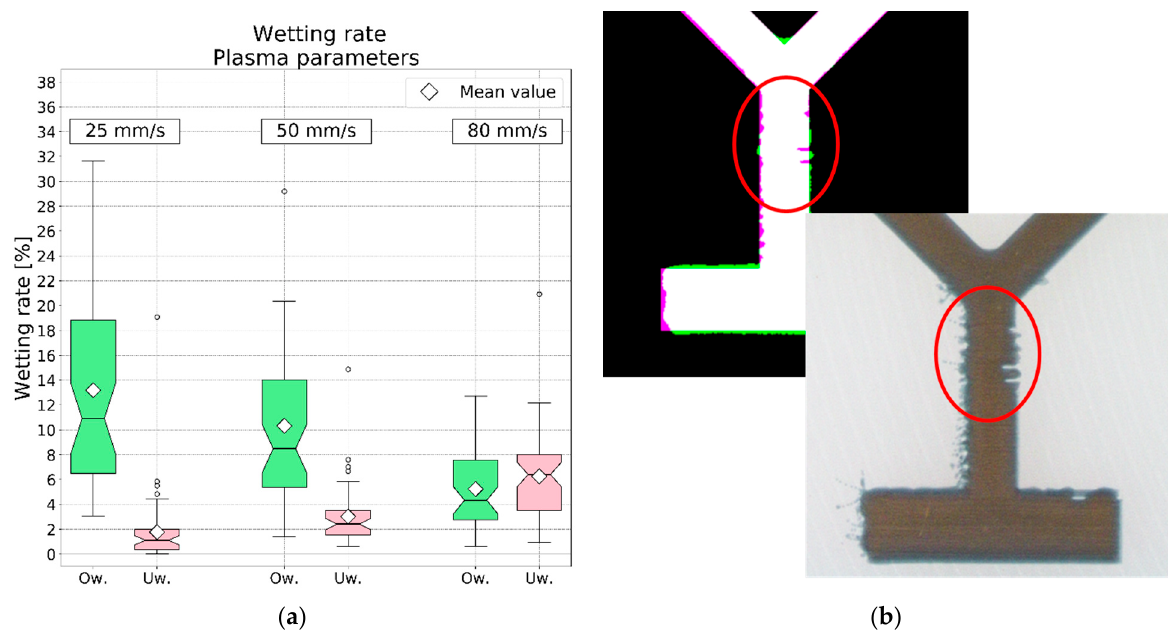
Figure 8. ( a ) Box plot diagram of wetting rates including overwetting (Ow.) and underwetting (Uw.) by varied plasma parameters ( b ) Example of a 50 mm/s treated L8 sample displaying function critical narrowing inside the red circles.